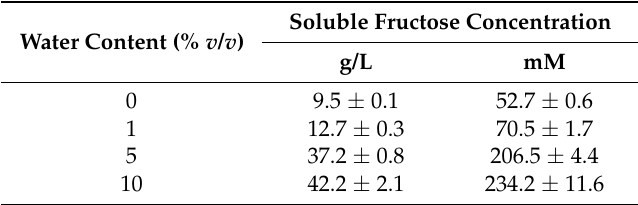
Table 2. Solubility of fructose in tert ‐ butyl alcohol/water systems at 35 °C.